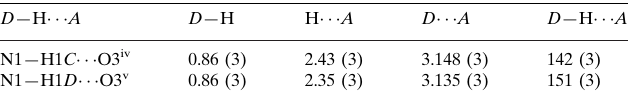
Hydrogen-bond geometry (A˚ , (cid:3)